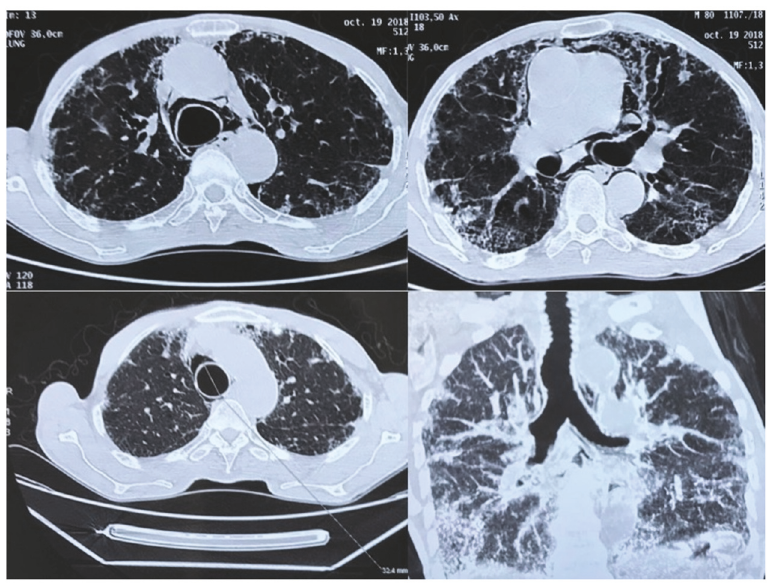
Figure 2: CT scan showing tracheal and both main bronchi dilation with associated